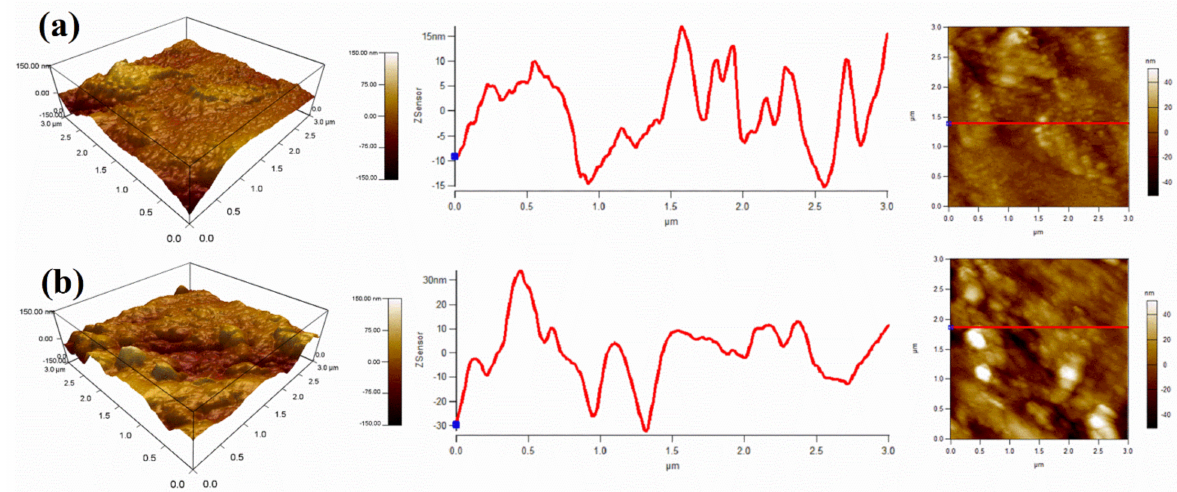
Figure 10. AFM analysis of ( a ) steel in absence of IMD, and ( b ) steel substrate in the presence of IMD.